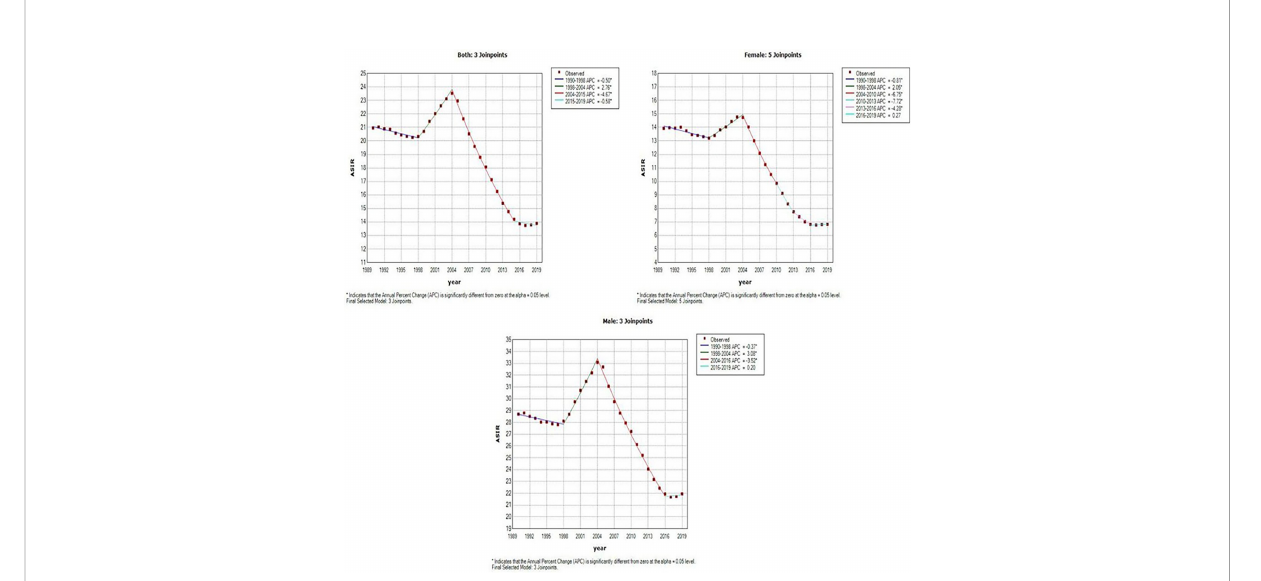
Figure 4 and Table 2 present the joinpoint analysis of trends in the ASMR of EC in China from 1990 to 2019. The ASMR decreased from 1990 to 1998, rose from 1998 to 2004, and then decreased again from 2004 to 2019 in both sexes, with overall AAPC values of − 1.8 ( − 1.9, − 1.7). In females, the ASMR decreased